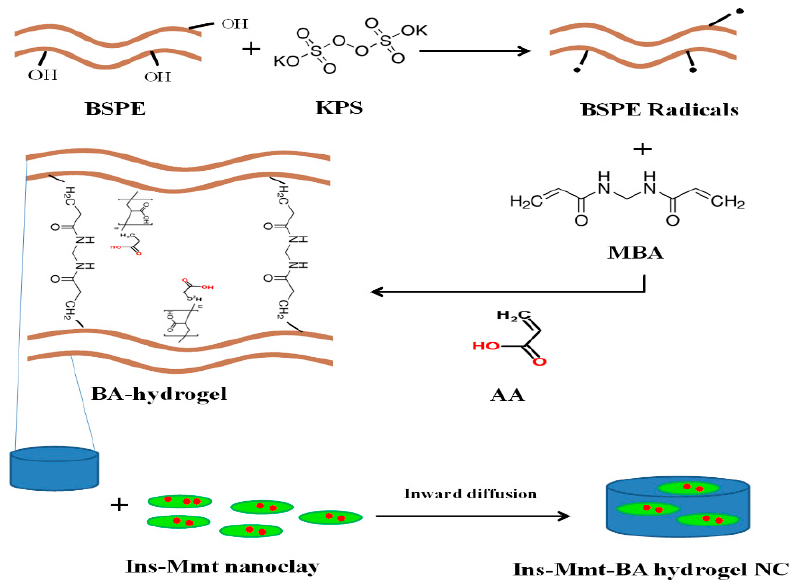
Figure 1. Proposed structure of black seed polysaccharide extract (BSPE)-g-poly (acrylate) hydrogel (BA hydrogel) and insulin intercalated montmorillonite clay (Ins-Mmt)-loaded BA hydrogel nanocomposite (Ins-Mmt-BA hydrogel NC).